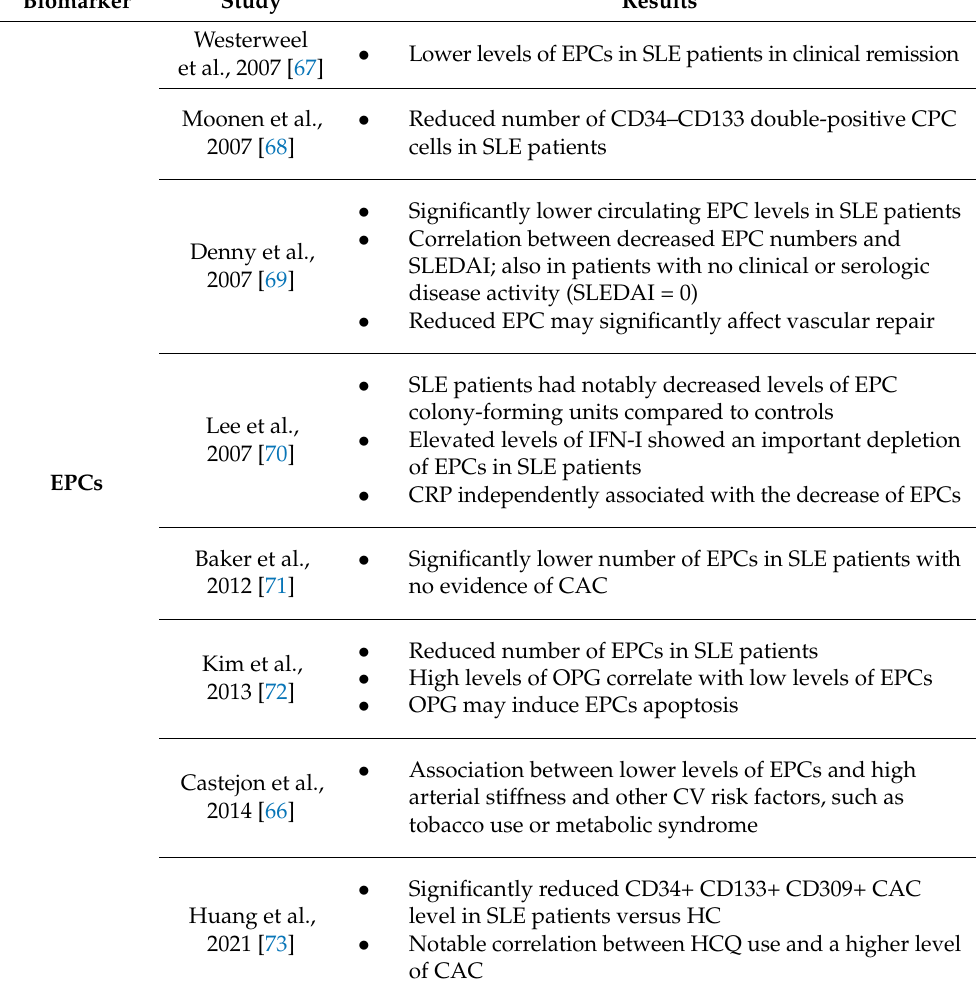
Table 2. Endothelial progenitor cells and the relation with SLE